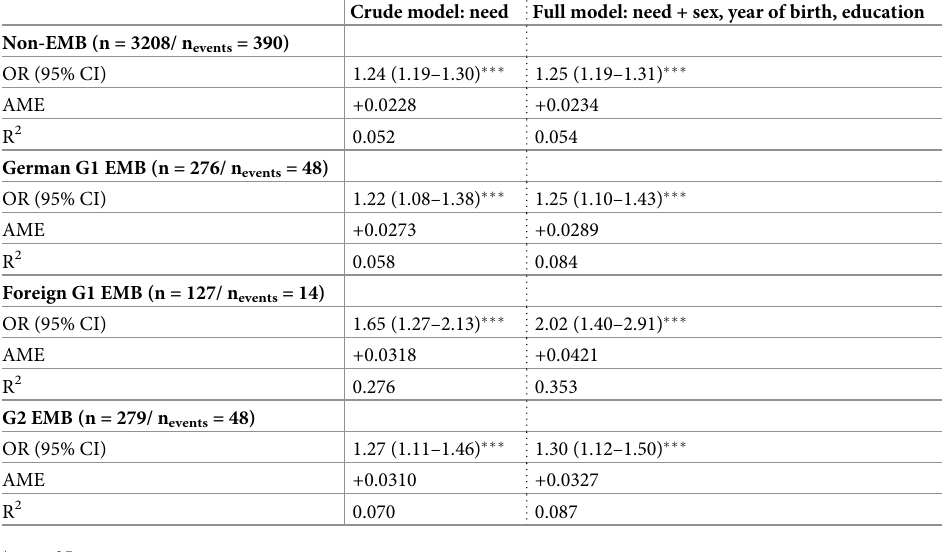
Table 3. Stratified logistic regressions for the utilization of rehabilitation services depending on the need for reha- bilitation and further sociodemographic variables (weighted results). Crude model: need Full model: need + sex, year of birth,